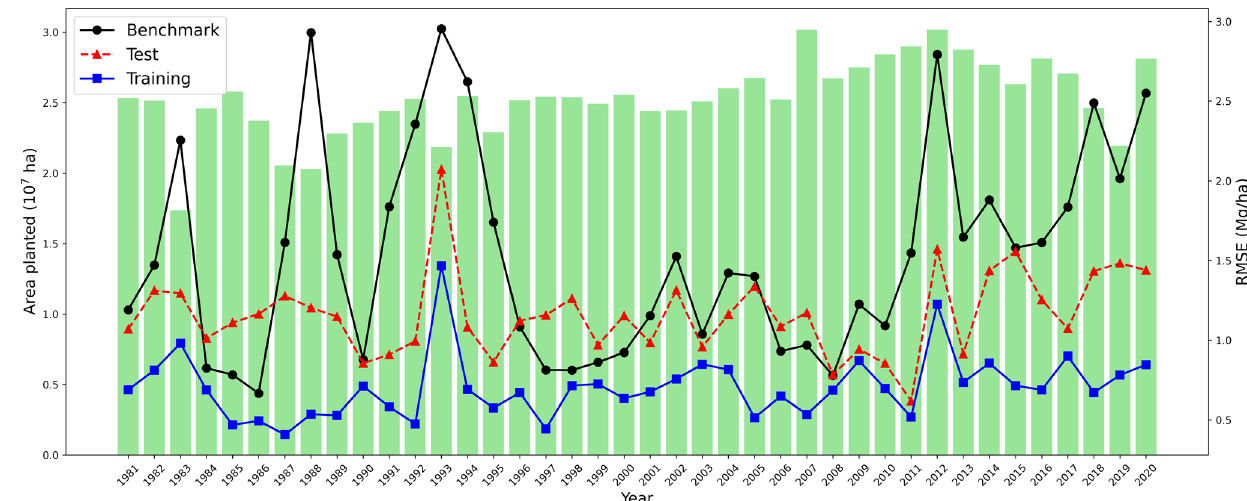
Fig. 4 Temporal extrapolation results. Green bars are average planted areas from 1981 to 2020. The three curves represent the benchmark nearest-year approach, data-driven crop model on test data and training